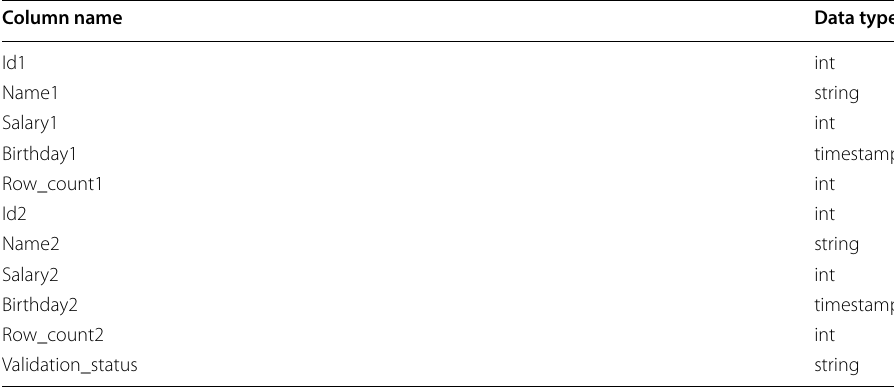
Table 5 Validation database schema—“Users_row_delta"